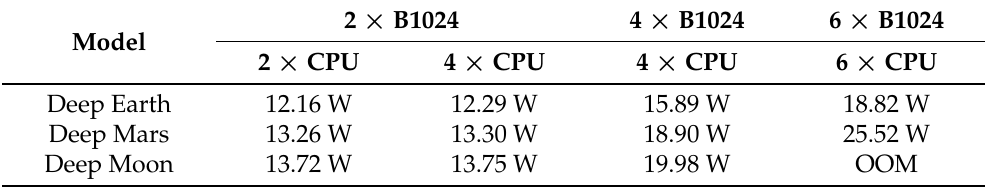
Table 19. The peak power consumption during benchmarks for B1024 DPU architecture.